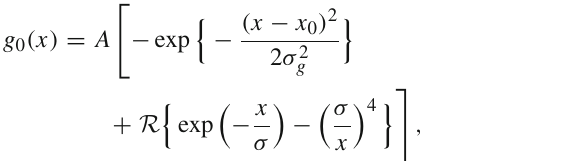
Fig. 4 The difference between the binned events and their smooth fit by the ATLAS fitting function [Eq. (5)] obtained for the qX → γγ